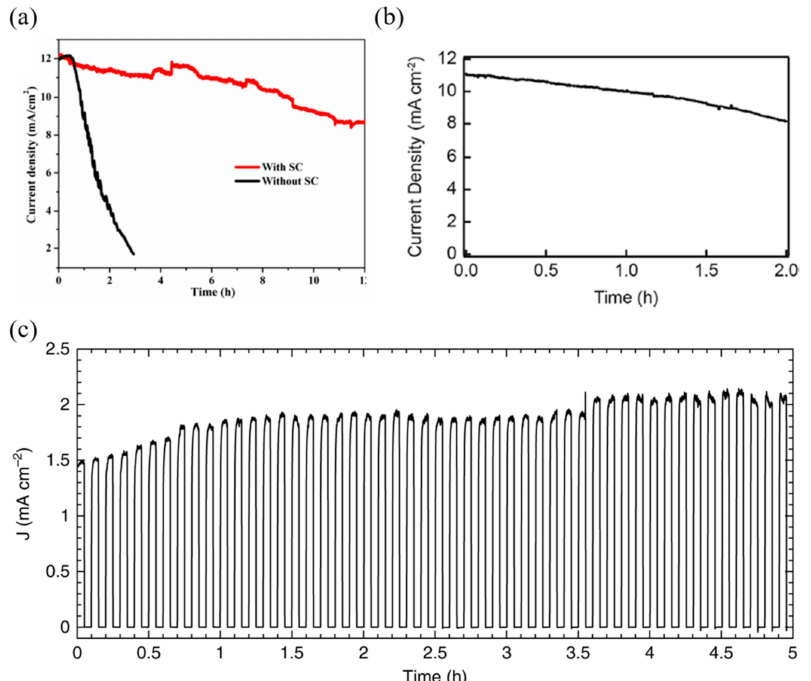
Figure 11. Cases of improving stability by passivation. ( a ) Current versus time graph of a perovskite photoanode at an applied potential of 1.23 V versus RHE under simulated AM 1.5 G solar illumination (100 mW / cm 2 ) in 1 M KOH solution. ( b ) Photocurrent density versus time of a photocathode with a nominally 15 nm thick Pt catalyst under continuous illumination. The electrode potential was held at 0 V vs. RHE during continuous illumination of 0.5 Sun. ( c ) Chronoamperometric trace recorded at an applied potential of 1.23 V RHE in KOH electrolyte solution at pH 12.5, under chopped simulated solar light irradiation (AM 1.5 G, 100 mW / cm 2 )